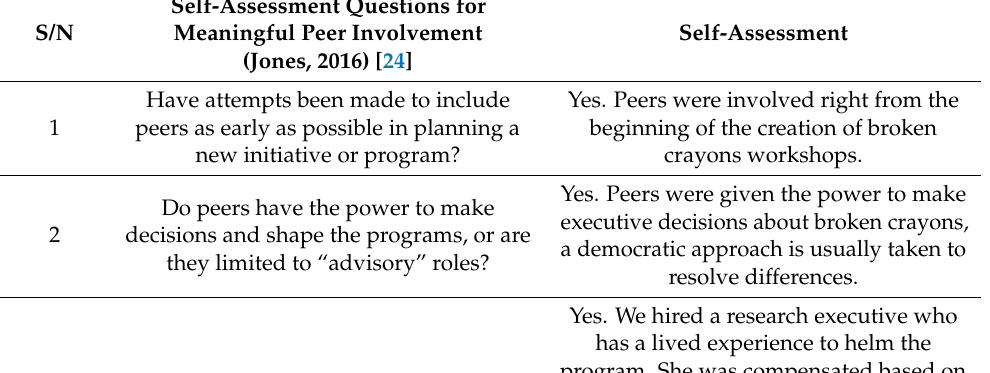
Table 2. A self-assessment exercise to ensure meaningful, non-tokenistic involvement of peers in the development and implementation of Broken Crayons